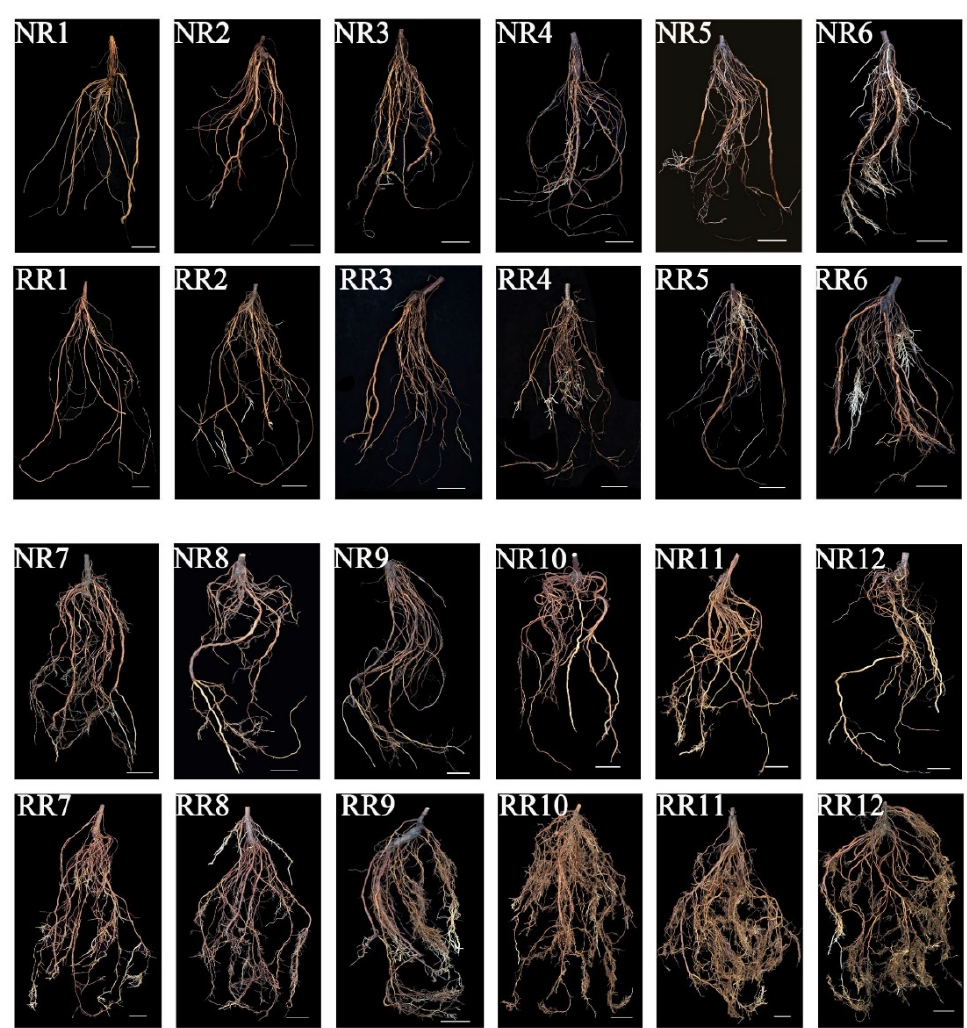
Figure 1. The developmental root system morphology of one-year-old self-rooted grapevine cv. “Muscat Hamburg” under NR and RR. Twelve different sampling points were recorded as NR1–12 and RR1–12, respectively. Scale bar = 5 cm.